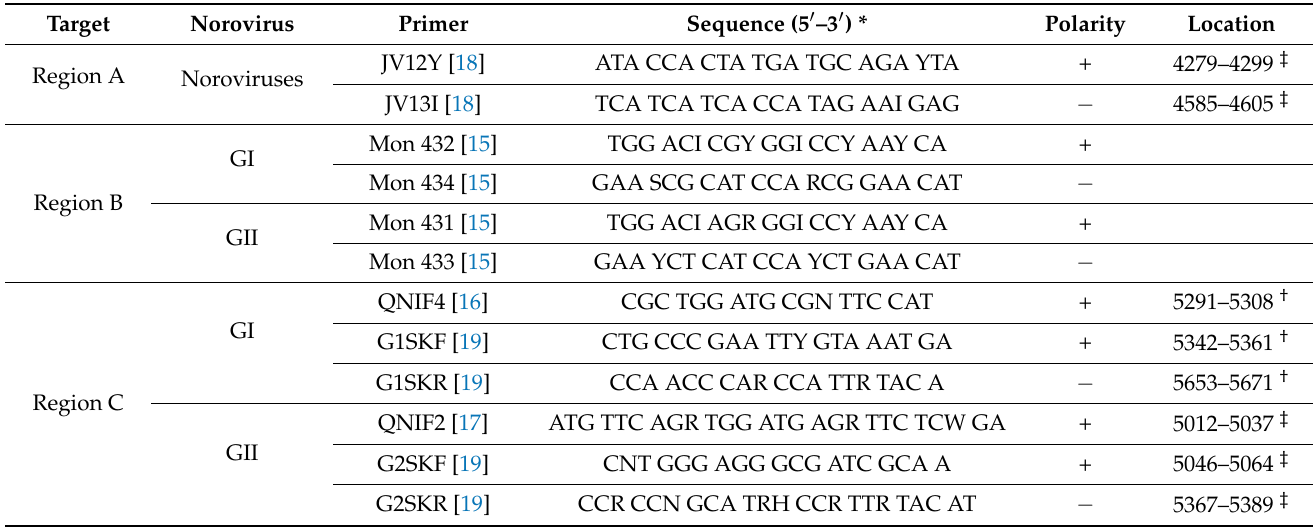
Table 1. Primer sequences used for real-time RT-PCR, RT-PCR and genotyping of norovirus GI and